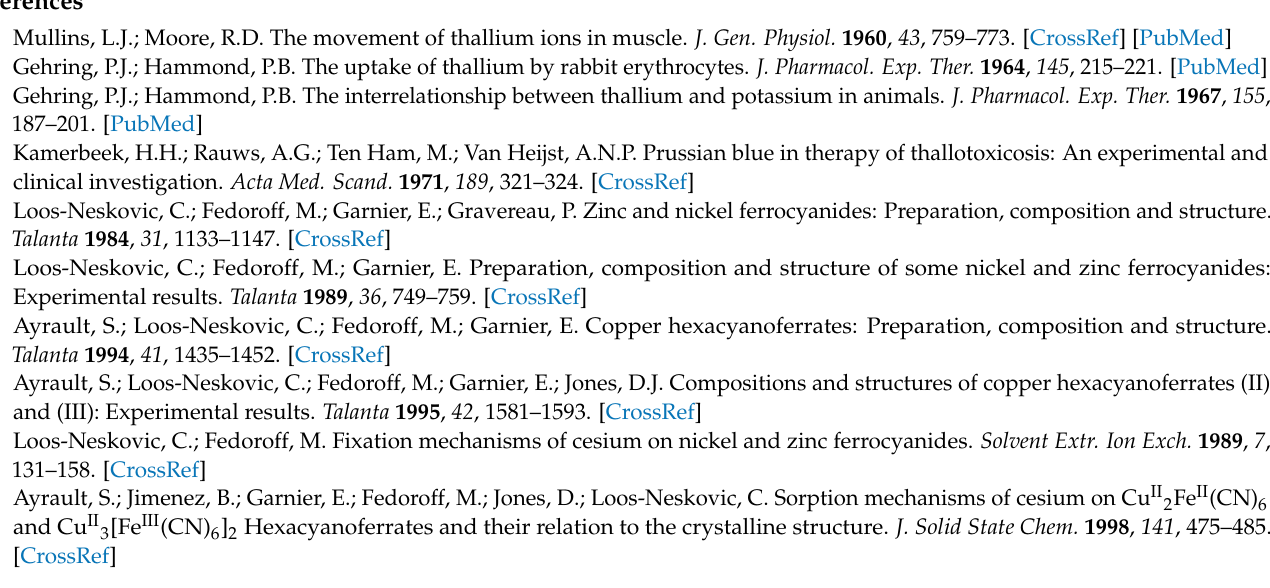
of 2 ; Figure S3: IR spectrum of 3 ; Figure S4: IR spectrum of 4 ; Figure S5: IR spectrum of 5 ; Table S1: Crystal data and structure refinement for 1 – 5 ; Table S2: Selected bond lengths (Å) and angles ( ◦ ) in 1 – 5